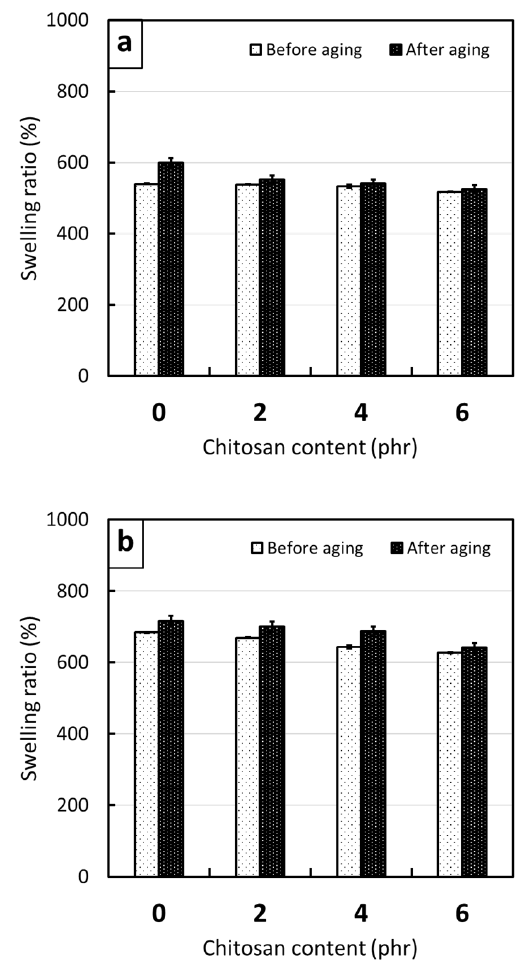
Figure 5. SEM images showing morphological properties of ( a ) pristine R-VNRL, ( b ) pristine RP- VNRL, ( c ) 6-phr CS/R-VNRL composites, and ( d ) 6-phr CS/RP-VNRL composites. All images are at a magnification of ×20,000.